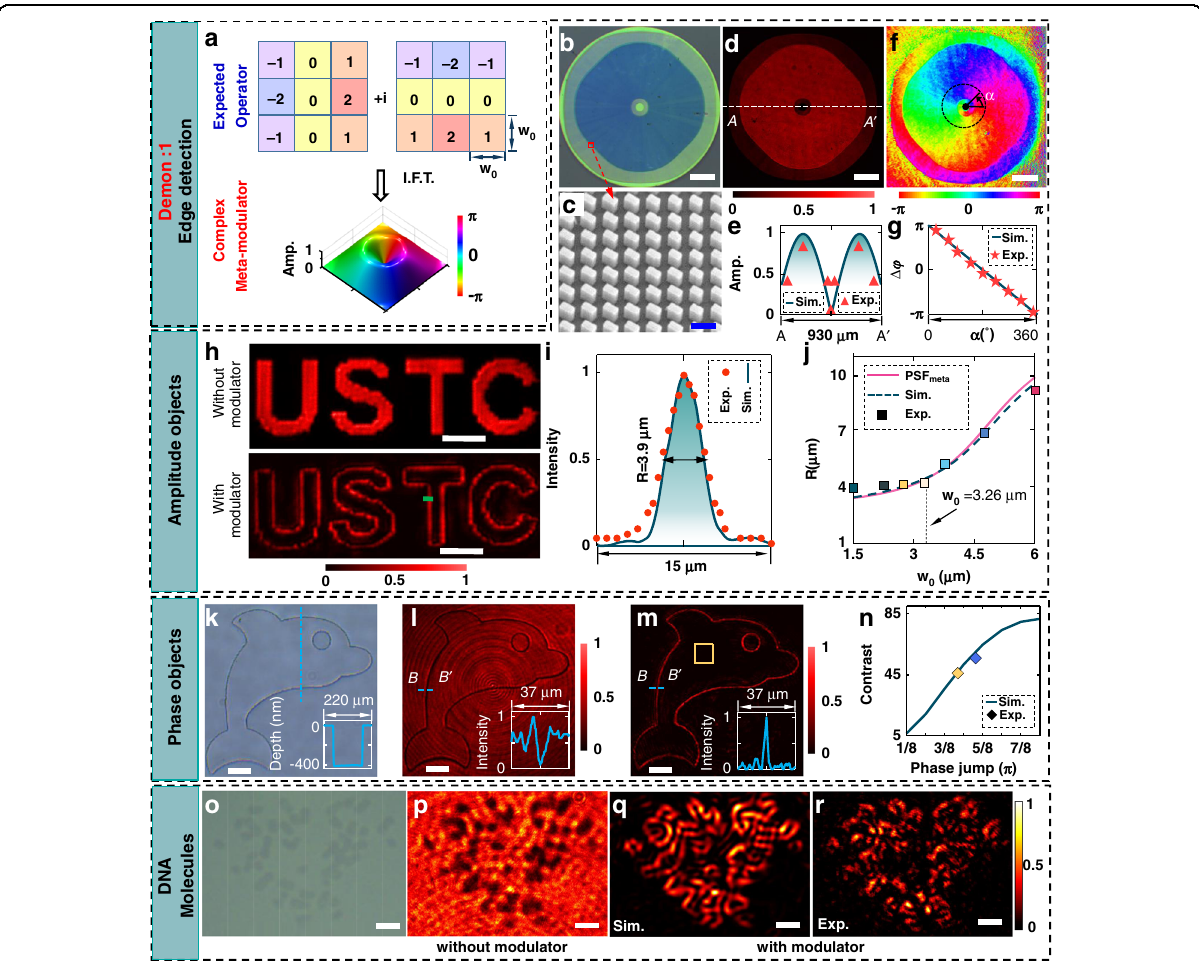
Fig. 2 Edge detection. a Illustration of the expected operator (upper panel) for edge detection and its corresponding meta-modulator (lower panel) with amplitude and phase pro fi les. b , c Microscopic ( b ) and SEM ( c ) images of the fabricated meta-modulator with the corresponding w 0 = 1.5 μ m. The colors in the microscopic image ( b ) originate from the wavelength-dependent re fl ection of different nanobricks. Scale bars: 100 μ m ( b ); 300 nm ( c ). d Transmission (cross-polarization part) of the fabricated meta-modulator under the circular-polarized illumination. Scale bar: 100 μ m. e Simulated (curve) and experimental (triangles) line-scanning amplitude pro fi les along the line AA ′ (denoted in ( d )). The experimental amplitude is obtained by using a square root of the transmission in ( d ). f Retrieved phase pro fi les from the experimental interference patterns. The sign α denotes the azimuthal coordinate. Scale bar: 100 μ m. g Simulated (curve) and experimental (star) phase pro fi les along the azimuthal coordinate α . The presented phase is de fi ned as Δ φ = φ ( α ) − φ (0), which is used to remove the constant phase. h Measured images by a single metalens (without meta- modulator, upper panel) and the meta-imager (with meta-modulator, lower panel). Scale bars: 50 μ m. i Simulated (curve) and measured (dots) line- scanning intensity pro fi les along the green line in ( h ). The processed edges have the full width at half maximum (FWHM): R = 3.9 μ m. j Relationship between the widths of processed edges and the detection accuracy ( w 0 ) of the ideal modulator. Both simulated (dashed) and experimental (squares) results have good agreement with the predicted ones (solid curve) by using Eq. (1). The demonstrated metalens has the PSF with the size of 3.3 μ m, which determines the best resolving power of the proposed meta-imager. k Microscopic image of a dolphin pattern etched on a quartz substrate. The etching depth is around 400 nm (insert), which is measured by using a pro fi lometer. Scale bar: 50 μ m. l Transmitted image of this binary-phase dolphin. The dark intensity is caused by the phase discontinuity at the edge. The line-scanning intensity across the dark edge is plotted in the insert. Scale bar: 50 μ m. m Processed image by using the meta-imager at the magni fi cation M = 1. In the insert, the line-scanning intensity along the line BB ′ shows the clear edge that has a high contrast to the surrounding background. Scale bar: 50 μ m. n Dependence of the contrast (de fi ned as the ratio of the intensity at the edge to the background intensity) on the phase jump of the binary-phase object. To make a fair comparison with the simulated contrast (curve), we remove the background noise (caused by the transmitted co-polarization light) when calculating the experimental (diamond) contrast. The experimental background intensity is evaluated by using the average intensity encircled within the yellow square in ( m ), where the intensity is less in fl uenced by the diffraction of extracted edges due to the large distance from the edge. o Re fl ective microscopic image of DNA molecules. Scale bar: 5 μ m. p – r Outlining the edge of the DNA molecules. To match the resolution of our meta-imager, these DNA molecules undergo a magni fi cation of 4 by using an objective lens. The magni fi ed DNA molecules ( p ) are just located at the input plane of our meta-imager ( M = 1), which outputs the edges (see q in simulation and r in the experiment) of the DNA molecules at the image plane. Scale bars: 20 μ